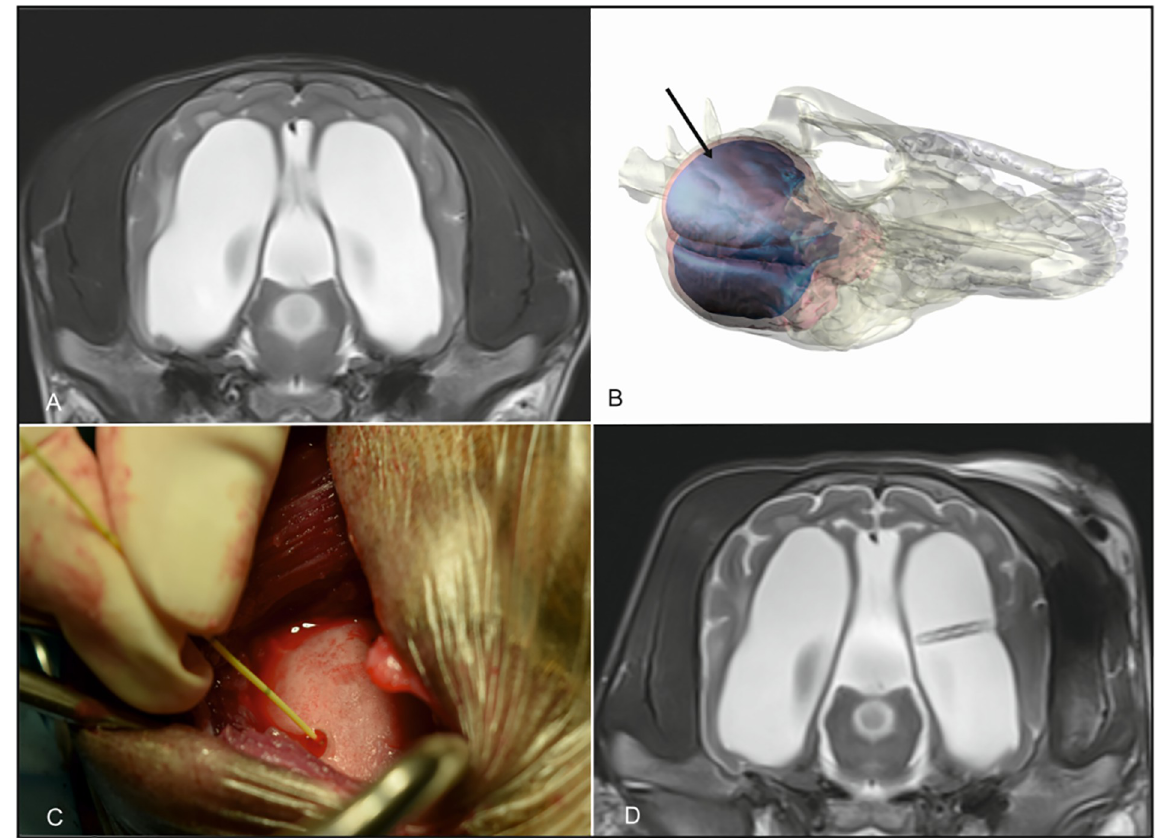
Fig 1. IVP measurement and Ventriculo-peritoneal shunt implantation and postoperative control in a Pomeranian with internal hydrocephalus. Maximum extension of the ventricles was determined in preoperative MRI (A). A small trephination was performed at the level of the caudal ectosylvian sulcus in the temporal lobe and the cortex was exposed after dural incision (B, black arrow) The sensor is advanced into the ventricle and IVP is measured (C). The same opening is used to implant the ventricular catheter. Proper implantation as controlled in postoperative MRI